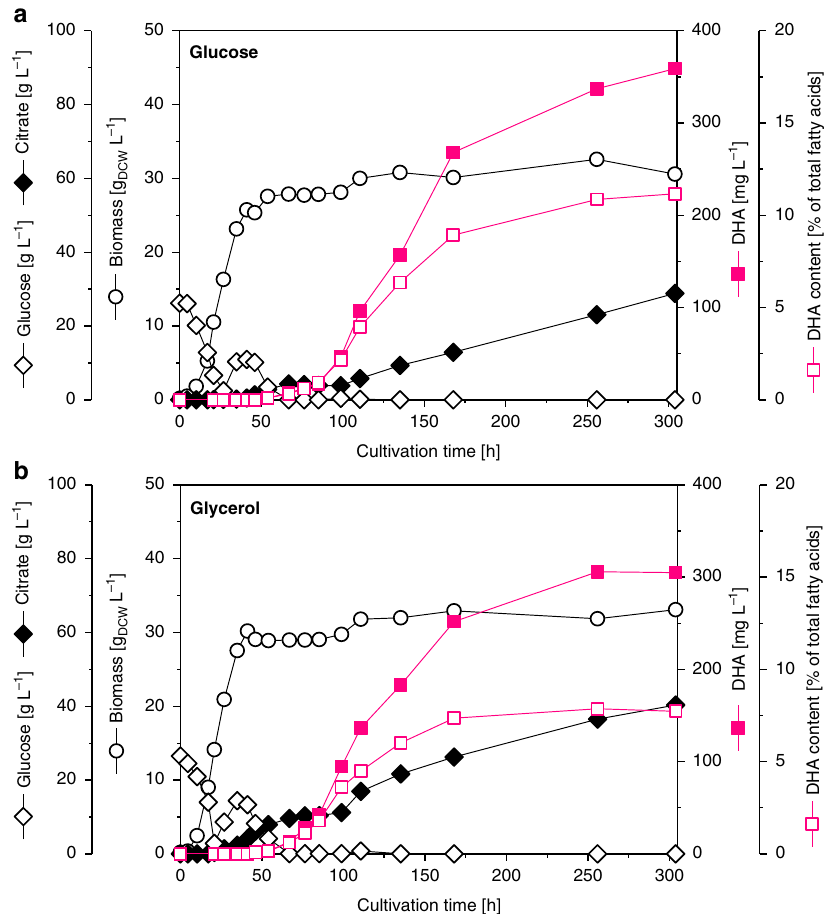
Fig. 5 DHA production in a fed-batch process. The designed producer Y. lipolytica Po1h::Af4 was grown in minimal medium on either glucose or glycerol as sole carbon source. Fermentation was conducted at 28 °C, pH 5.5, and a dissolved oxygen level of 5% during the feed phase. Substrate feeding was initiated upon carbon depletion. Coef fi cients of variation (CVs) across biological replicates were below 5% for biomass, substrate, and citrate levels, and below 10% for PUFA and native fatty acid content. Source data are provided as a Source Data fi